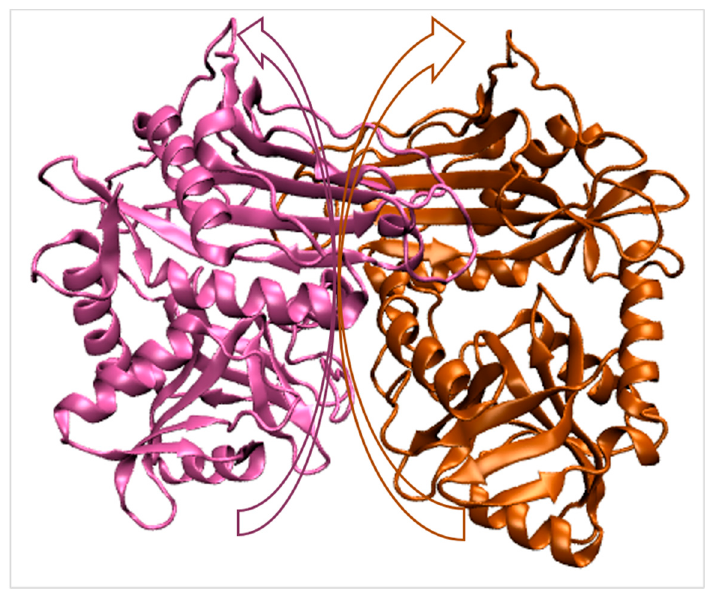
Figure 2. Crystal structure of BCAT enzyme catalyzing the BCAA degradation (PDB: 5BWR). The different colors indicate the two-domain structures of the BCAT subunit. The arrow interface represents the position of the domain interface.